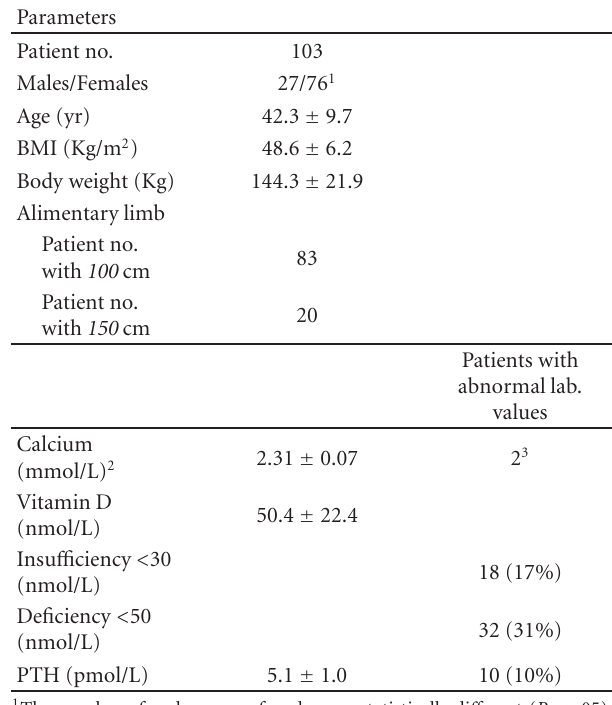
Table 1: Preoperative demographics and laboratory data prior to gastric bypass surgery.